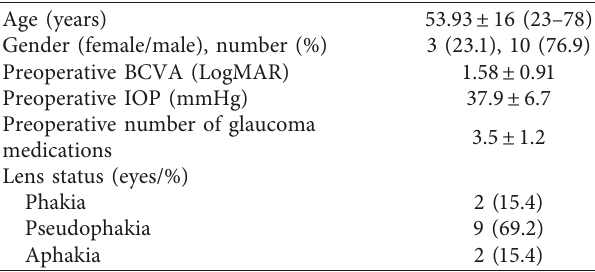
Table 1: Characteristics of the study